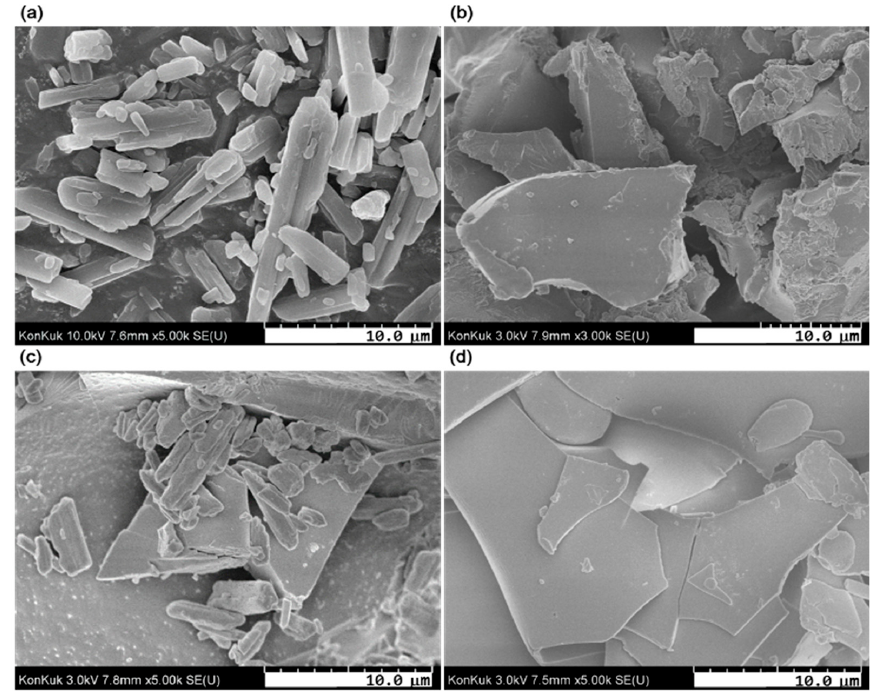
Figure 7. SEM images of ( a ) atrazine; ( b ) Cys; ( c ) atrazine/Cys physical mixture; ( d ) atrazine/Cys inclusion complex.